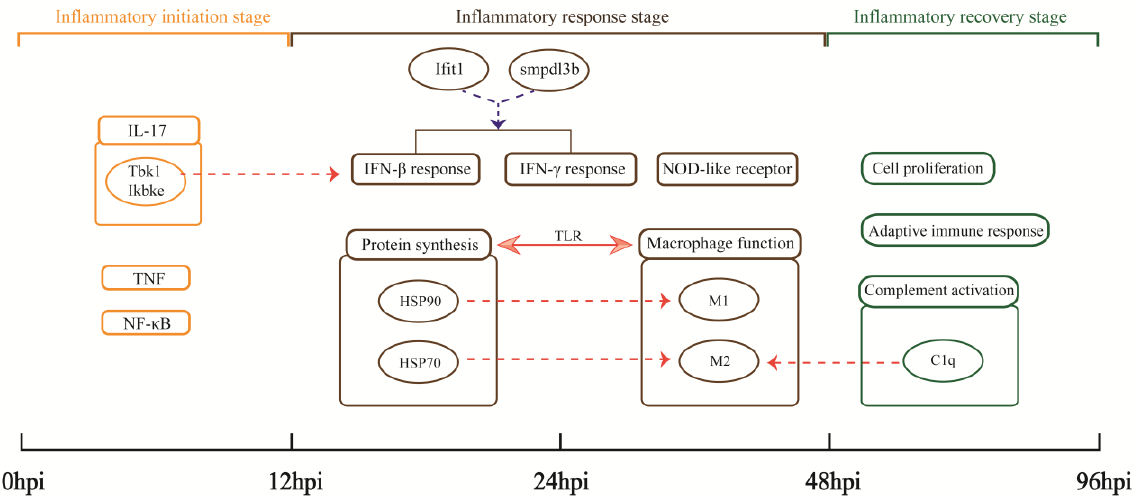
Figure 8. Important findings. Rectangles represent important biological processes or pathways. Circles represent important genes or the proteins they encode. Arrows indicate the existence of some relationship: the solid line shows the relationship directly discovered by the analysis in this study; the dashed lines indicate hypothesized relationships suggested by our analysis, with red indicating upregulation and blue indicating downregulation.